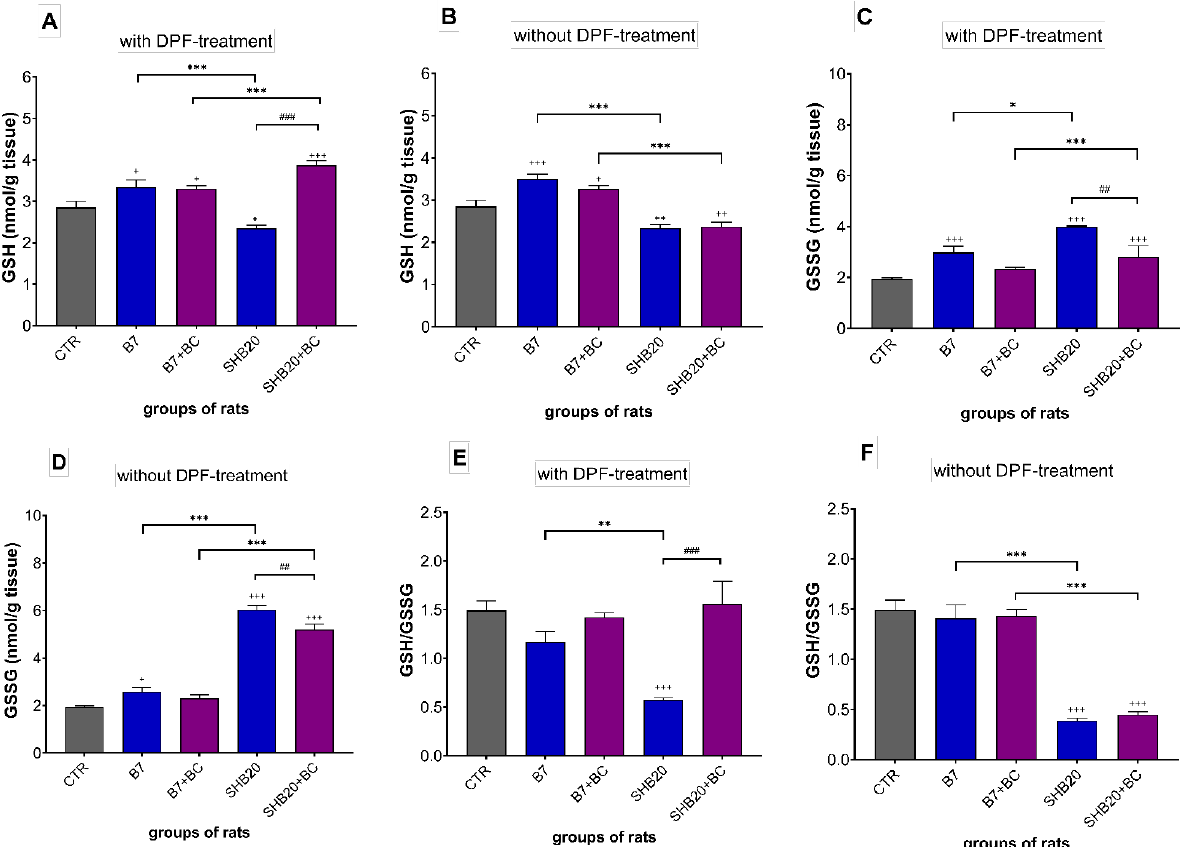
Figure 9. The concentration of reduced form of glutathione (GSH) ( A , B ), oxidized form of glutathi- one (GSSG) ( C , D ) and GSH to GSSG ratio ( E , F ) in the testes of rats exposed to DEE from B7 and SHB20 biofuels with and without DPF-treatment and with or without blackcurrant pomace supplementation (BC) for 28 days. Data are expressed as mean ± SEM. # — Statistically significant difference between normal and blackcurrant pomace supplemented diet, ## p < 0.01; ### p < 0.001); * — Statistically significant difference between B7 and SHB20 DEE, * p < 0.05; ** p < 0.01; *** p < 0.001); + — Statistically significant difference from the control group (CTR), + p < 0.05; ++ p < 0.01; +++ p < 0.001, one-way